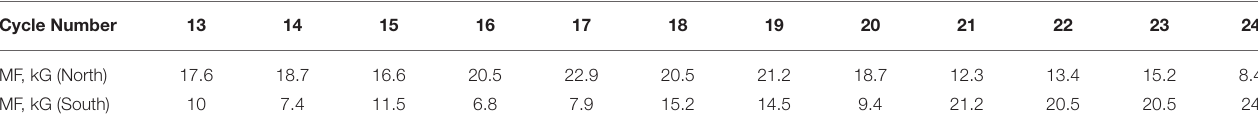
TABLE 3 | Estimated magnetic field strength (kG) using equatorial Poincare-Rossby waves for northern and southern hemispheres from GRO sunspot area data for solar cycles 13–24. Cycle Number MF, kG